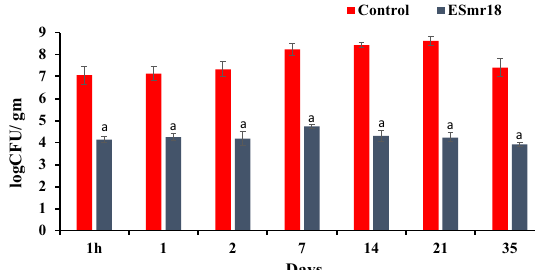
Fig. 5 The viable cell counts of Salmonella in S. enterica -inoculated chicken meat samples treated with sodium acetate buffer (vehicle) and crude ESmr18 stored at 7 °C. Error bars are representative of mean SD of the three independent experiments performed in ± triplicates. a Indicates significant (p < 0.05) difference on different days when compared with respective